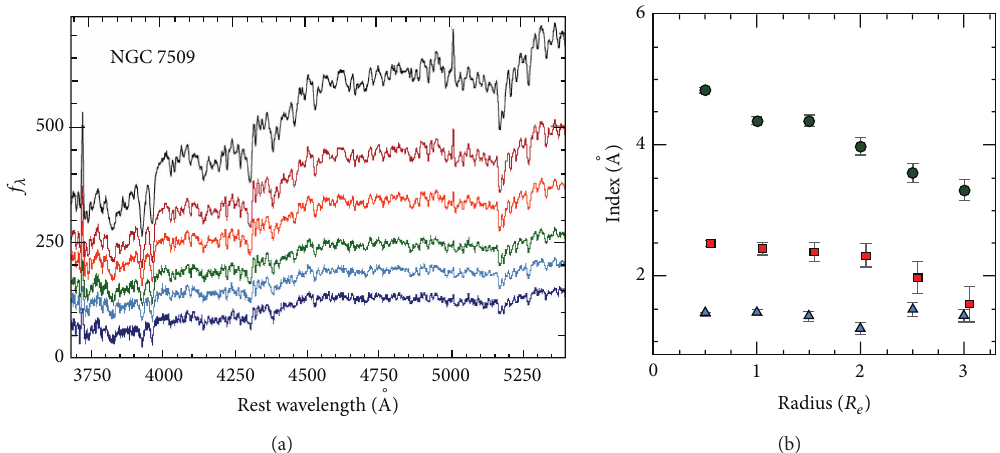
Figure 2: (a) Coadded spectra in elliptical annuli at 0 − 0.5 𝑅 𝑒 , 0.5 − 1 𝑅 𝑒 , 1.5 − 2𝑅 𝑒 , and 2 − 2.5 𝑅 𝑒 (from top to bottom) for NGC 7509. (b) Index EW radial profiles for Mg 𝑏 (green), ⟨𝐹𝑒⟩ (red), and H 𝛽 (blue). Taken from Greene et al. [21].